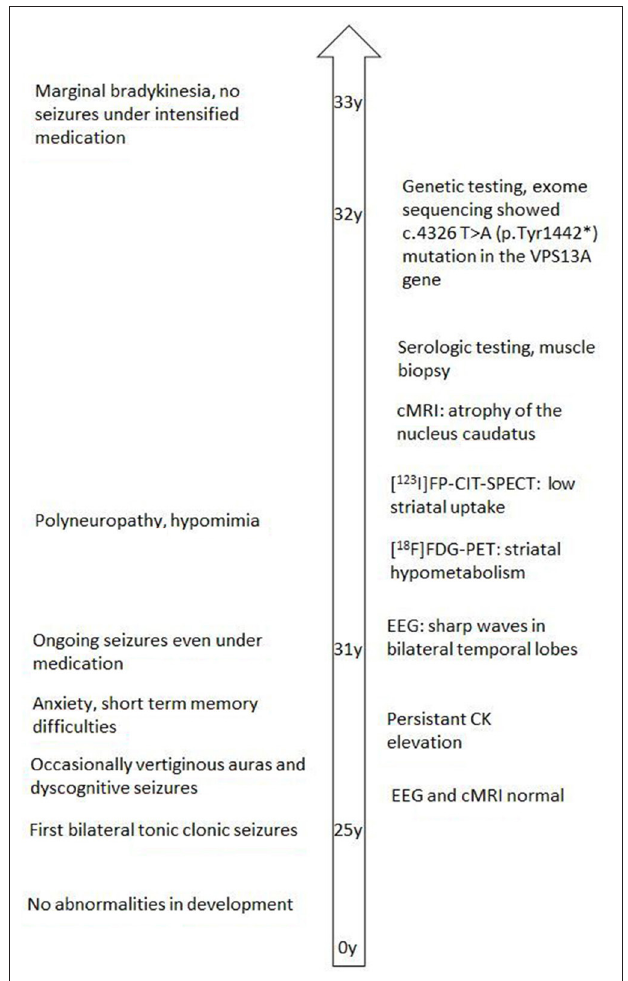
FIGURE 2 | Clinical and diagnostic course of the index